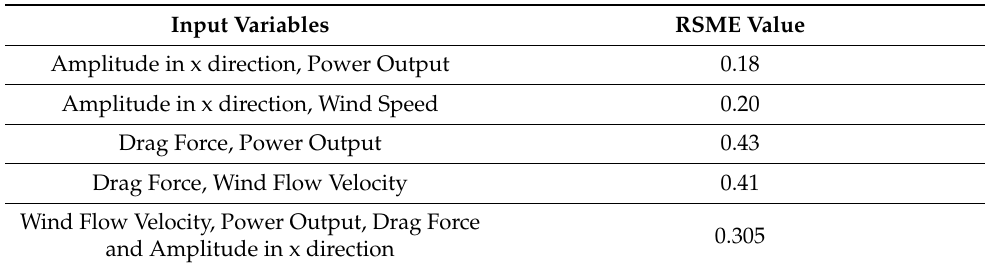
Table 4. The accuracy of the LSTM